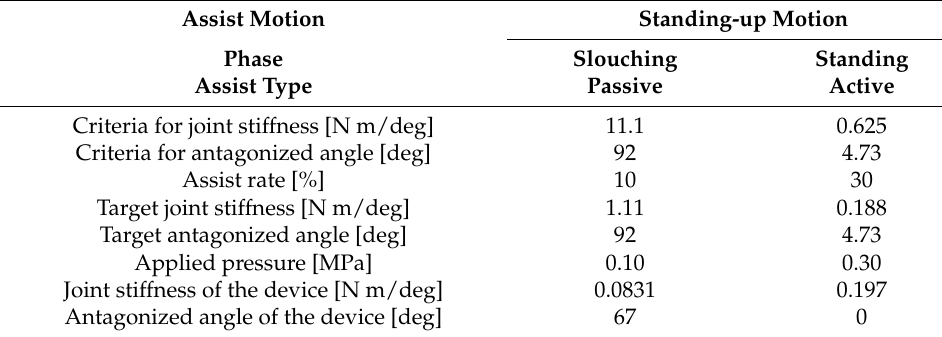
Table 4. Assist target values in the standing-up motion.